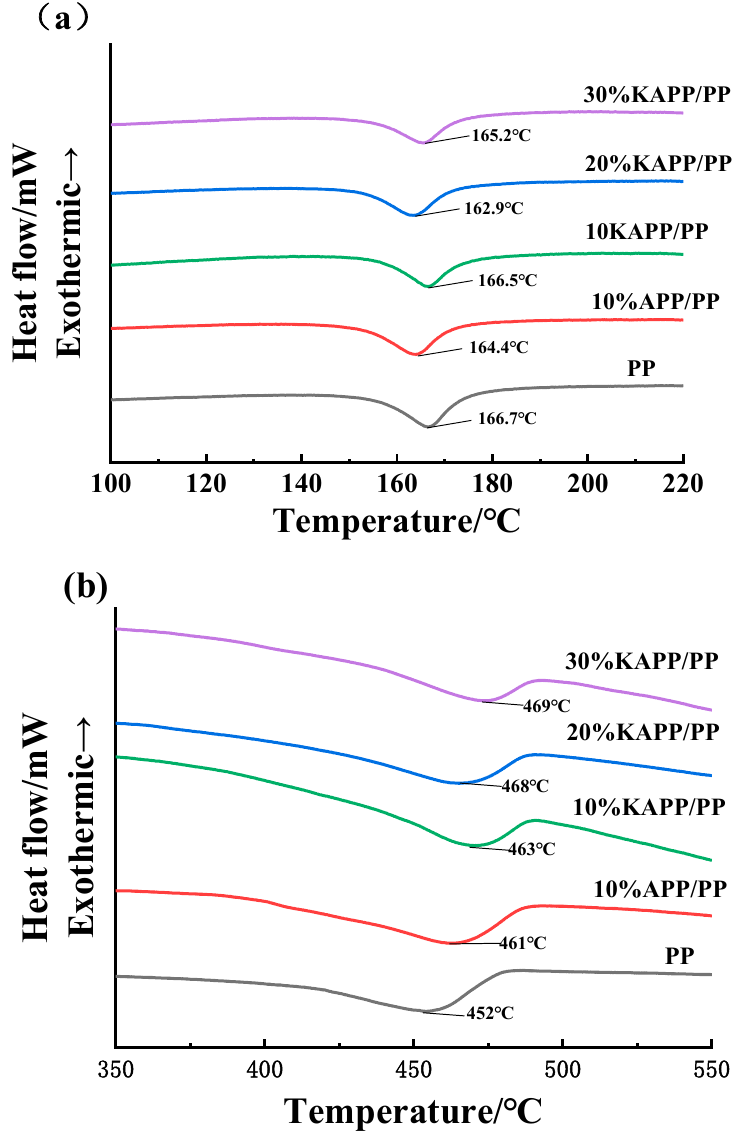
Figure 13. DSC curves for flame retardant PP. ( a ) DSC temperature range 100–220 °C; ( b ) DSC temperature range 350–550 °C.